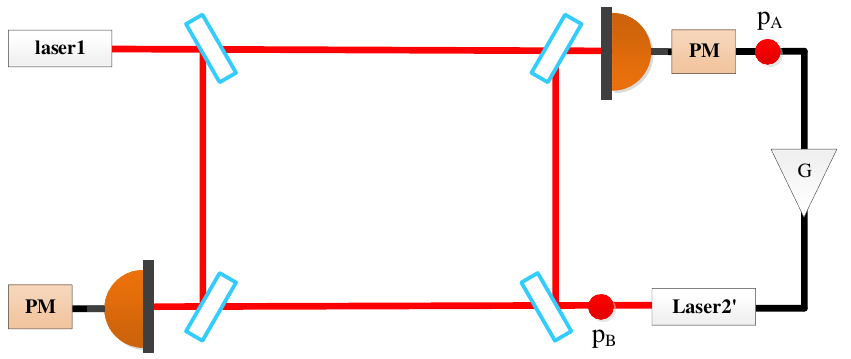
Figure 4. Simplified schematic of the LISA measurement scheme with